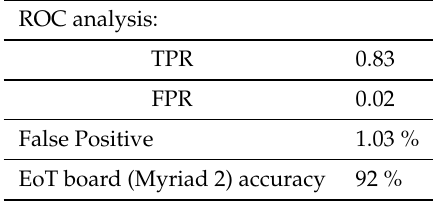
Table 3. Performance of the CloudScout model on the EoT board (Myriad 2).